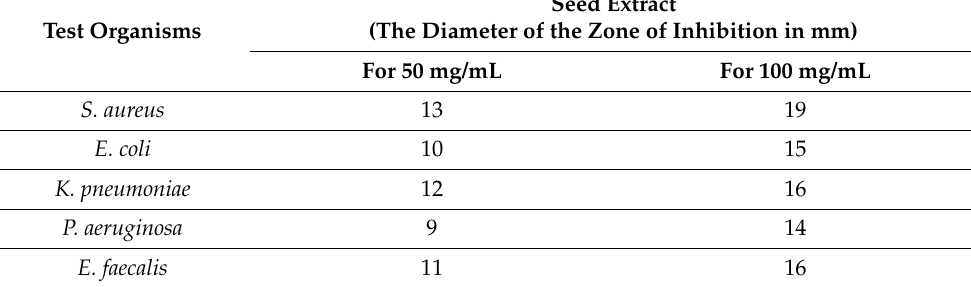
Table 4. MIC value against of seed extract different bacterial strains. Test Organisms